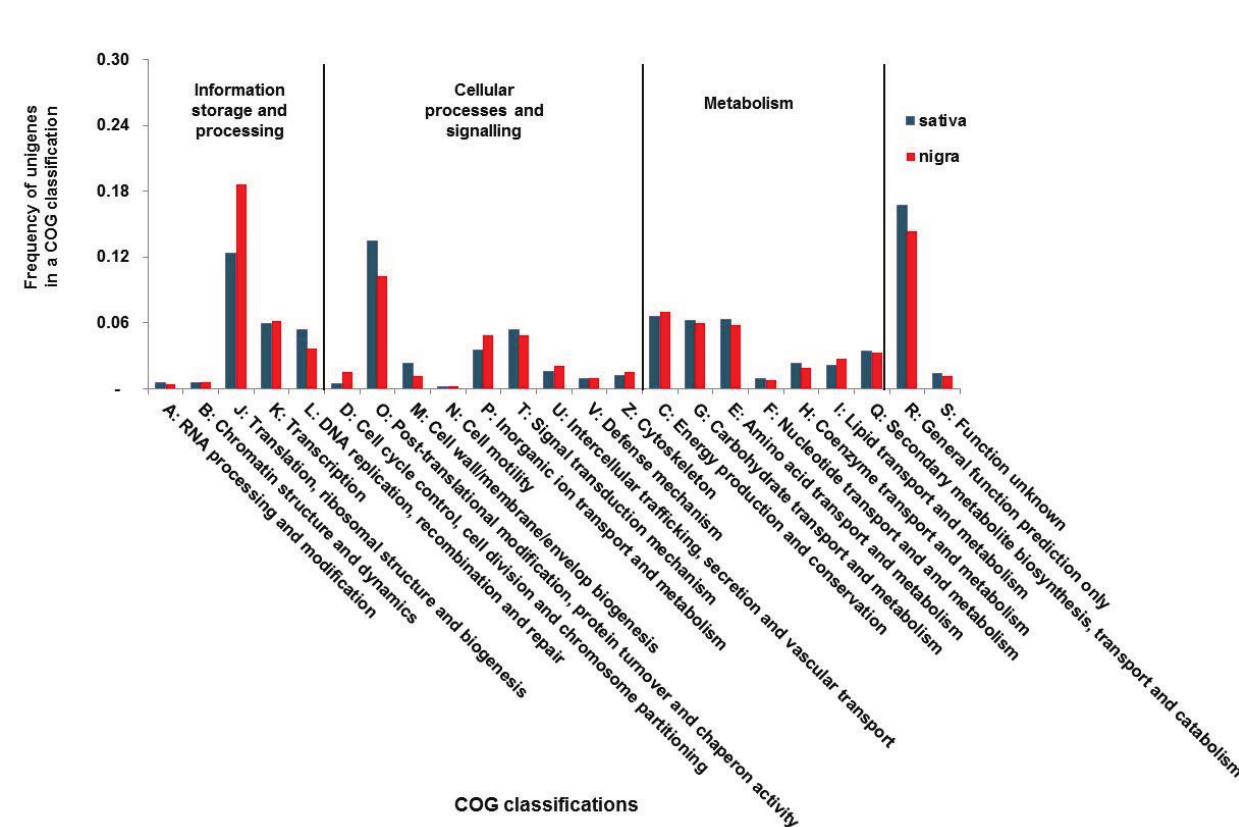
Figure 2. Cluster of orthologous groups (COG) classification between Vicia sativa nigra and sativa